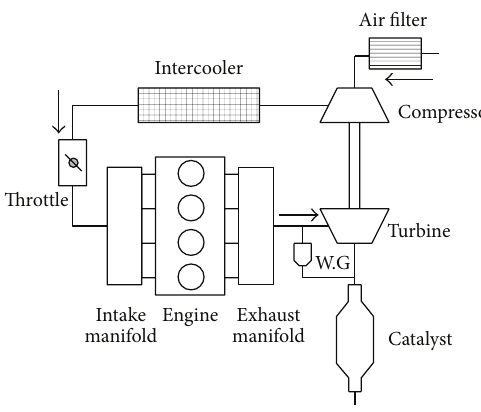
Figure 1: Sketch of the turbocharged SIDI engine.